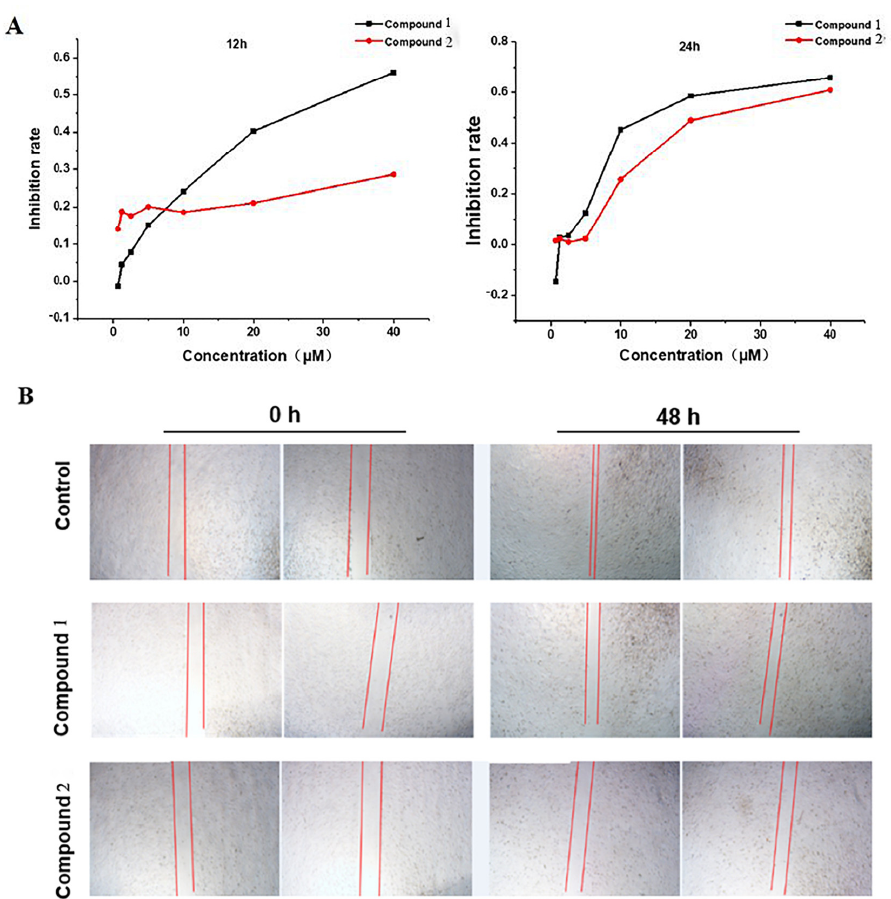
Figure 3. Cell proliferation and migration assay. ( A ) The inhibition rate of cell proliferation in HepG2 cells transfected with 1 and 2 was measured by MTT assay at 12 and 24 h. ( B ) A cell scratch assay evaluated the cell migration activity of compounds 1 and 2 by wound healing after 48 h.